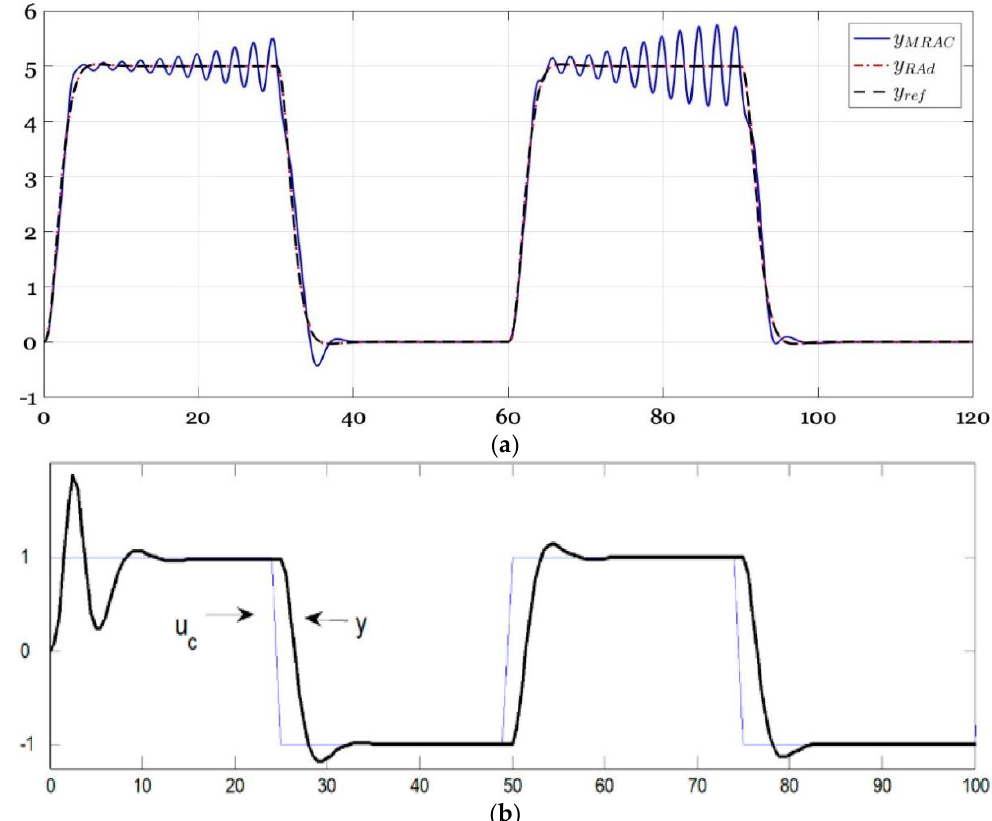
Figure 5. ( a ) Comparison of model reference adaptive control and robust adaptive control tracking square waves from [29]. Notice the square waves are rounded to reduce the deleterious challenge of discontinuity; ( b ) self-tuning regulators tracking square wave commands from [35]. Notice the square waves are not rounded, implying a relatively more challenging demand.